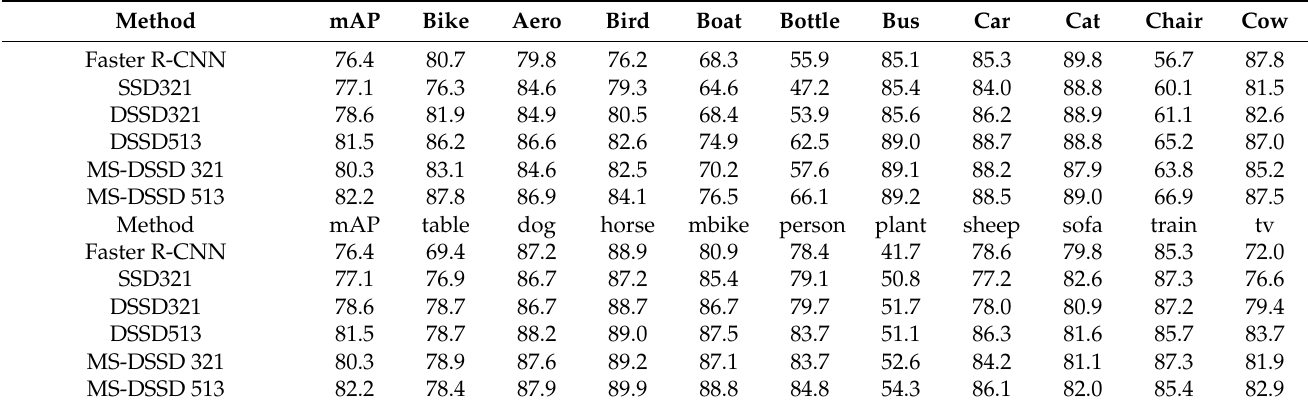
Table 1. Detection results using PASCAL VOC2007.